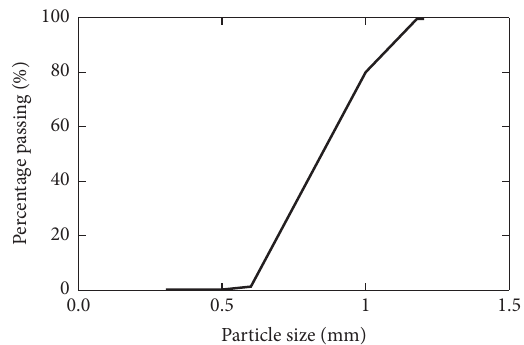
Figure 5: Grading curve of Leighton Buzzard sand (fraction B)